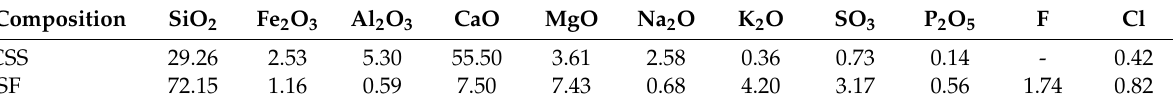
Table 1. Content of chemical composition for raw materials (calculated by mass fraction %).